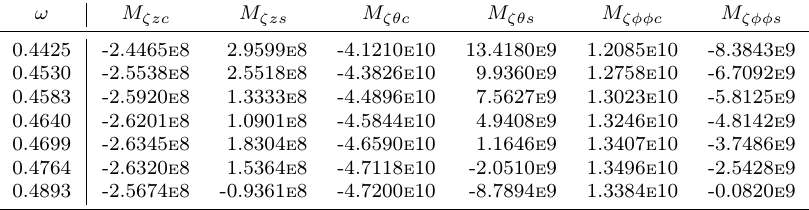
Table 15: Restoring force pitch